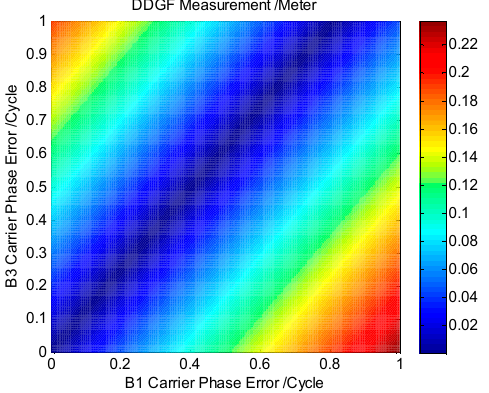
Figure 4. The relationship between the DDGF measurement and the carrier phase error in both frequencies.